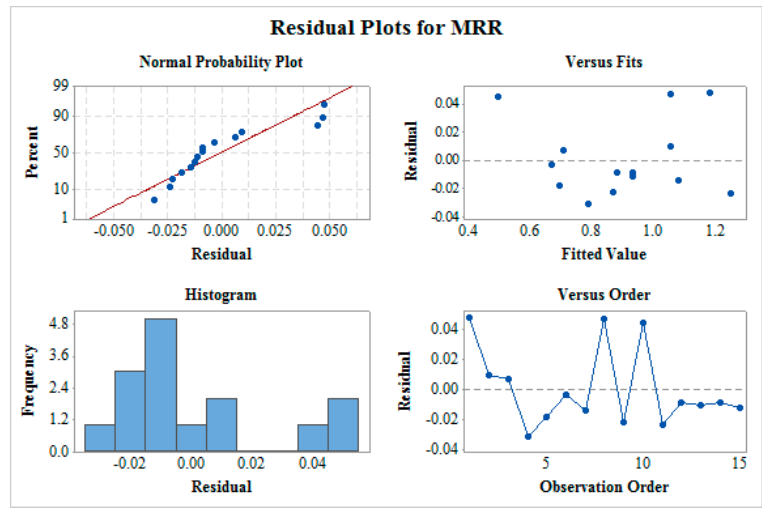
Figure 3. Residual plot for material removal rate (MRR).